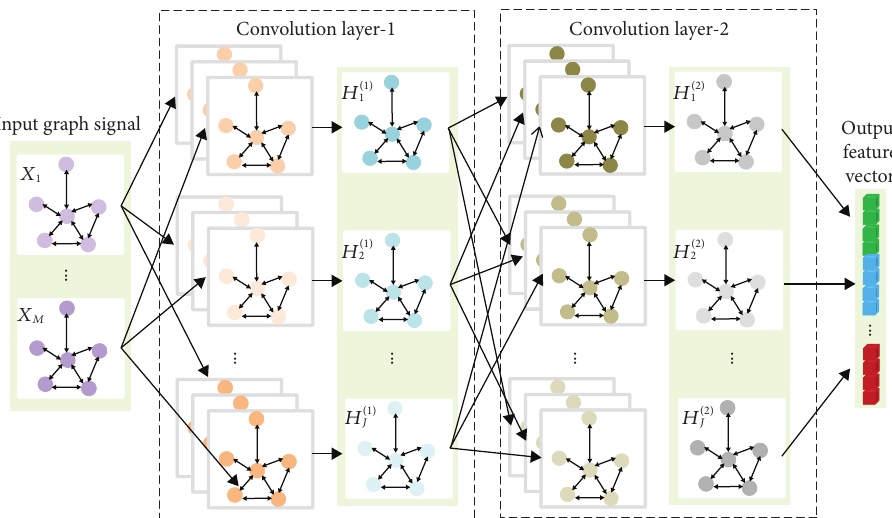
Figure 3: Schematic diagram of the feature representation of the graph network using two-layer convolution.